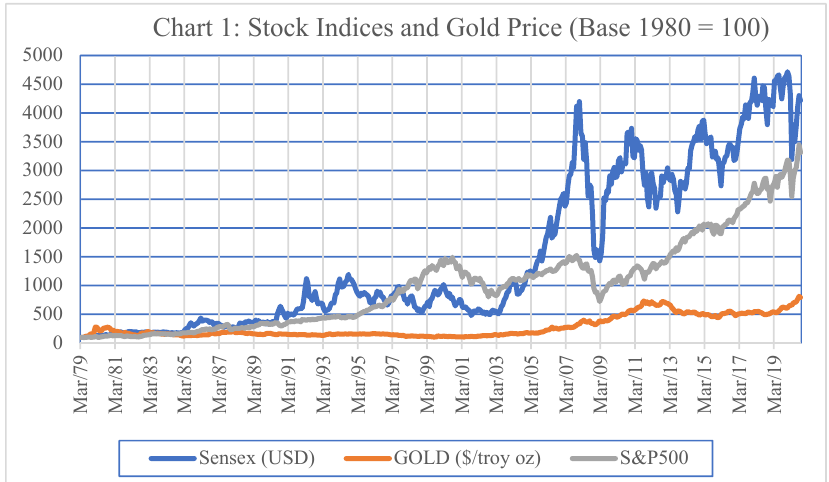
Chart 1: Stock Indices and Gold Price (Base 1980 = 100)